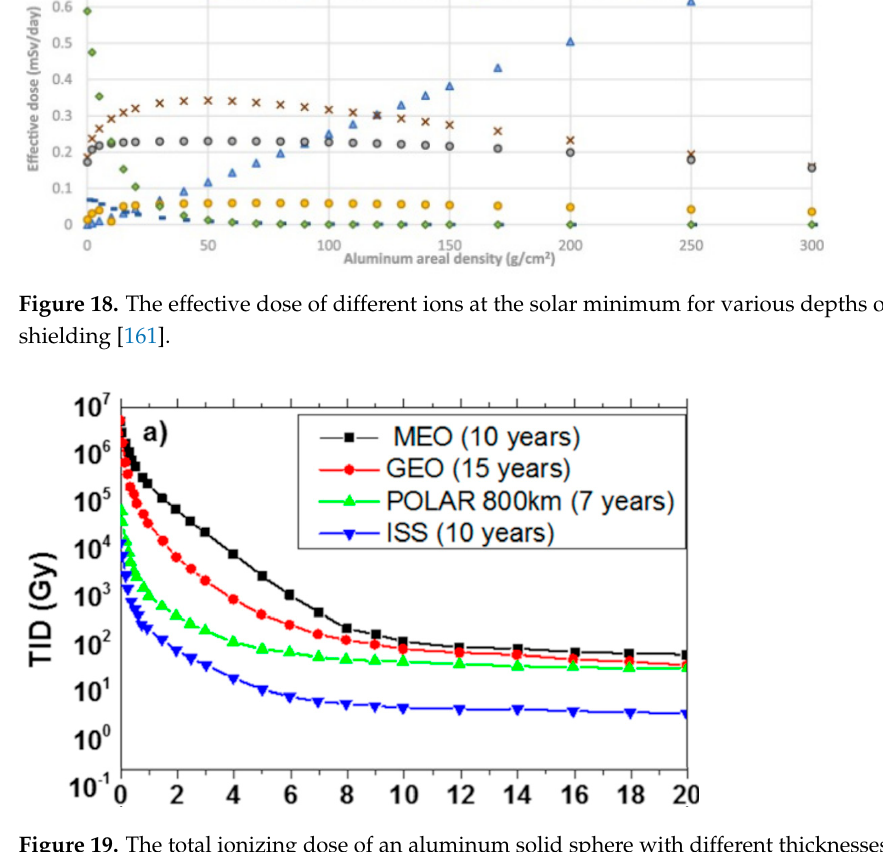
Figure 19. The total ionizing dose of an aluminum solid sphere with different thicknesses for various space mission [15].